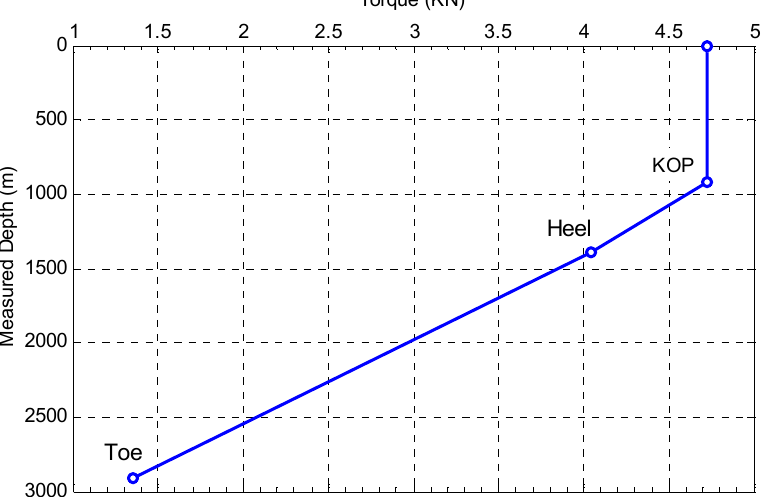
Figure 10. Distribution of torque along wellbore measured depth (RPM = 100 r/min).